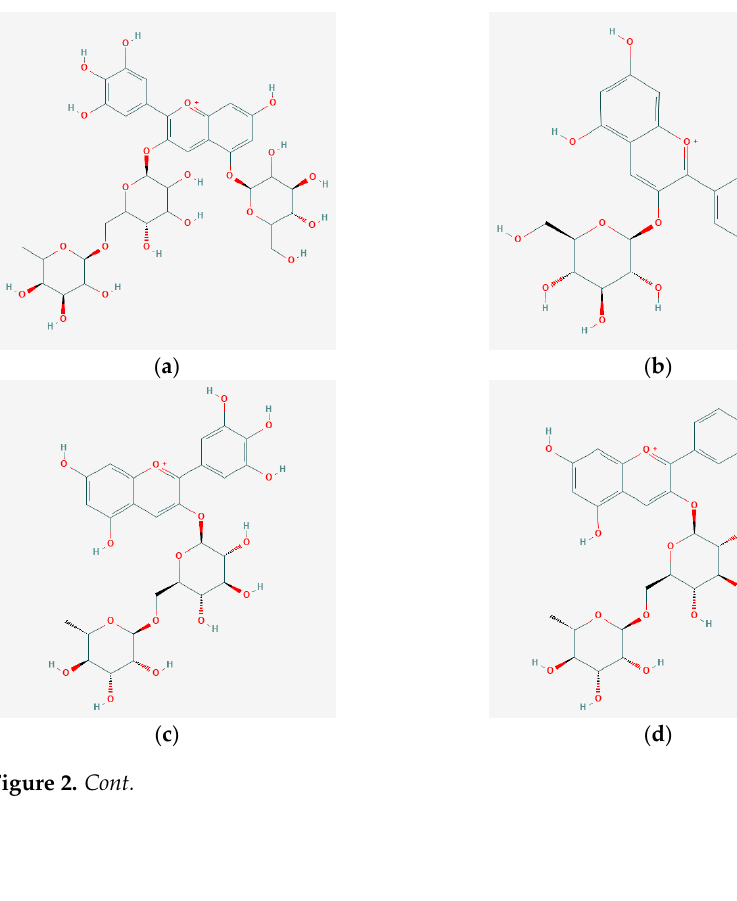
Figure 1. Chromatographic profile of eggplant peel extracts obtained by SLE with EtOH 96% for 30 min at 50 °C ( a ) and UAE with EtOH 96% for 30 min at 25 °C ( b ): Peak 1—delphinidin 3- O -rutinoside-5-glucoside; Peak 2—delphinidin 3- O - glucoside; Peak 3—delphinidin 3- O -rutinoside; Peak 4—cyanidin 3- O -rutinoside; Peak 5—petunidin 3- O -rutinoside.